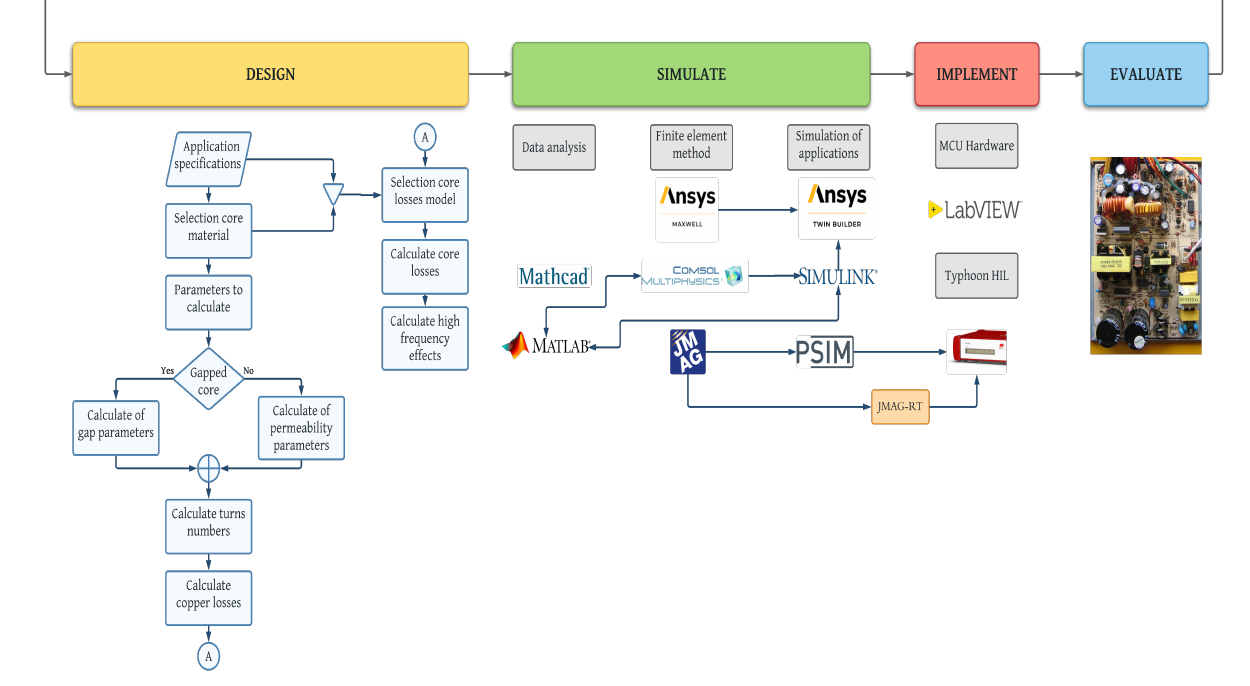
Figure 8. Steps to design a magnetic component. Source: Adapted from